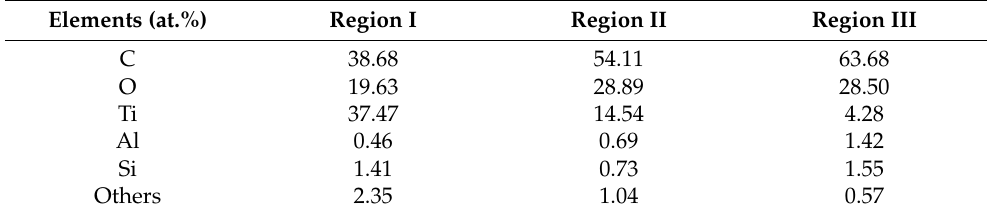
Table 6. Chemical compositions of materials in regions I, II, and III in Figure 4b, determined by SEM.